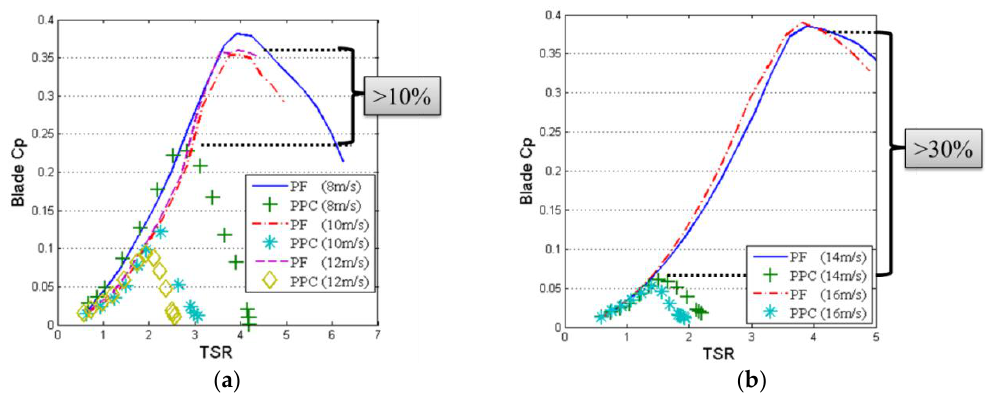
Figure 13. Experiment data of PF and PPC at 4 m/s to 16 m/s.